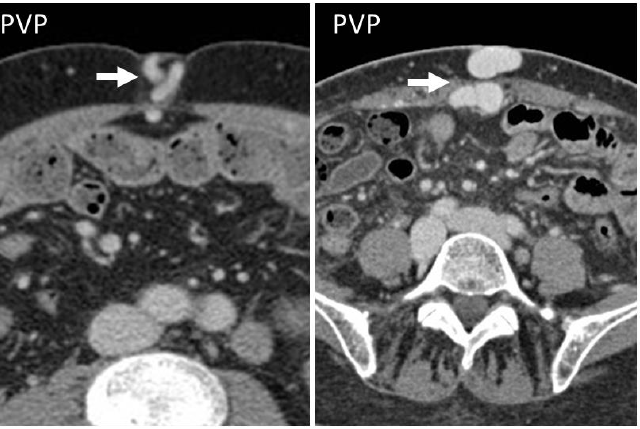
Figure 8. CT appearance of “caput medusae” on axial, contrast-enhanced CT scan on portal venous phase in two cirrhotic patients, as a result of the recanalization of the umbilical vein due to portal hypertension. This appearance is due to tortuous vessels (arrows) reaching the abdominal wall at the level of the navel.